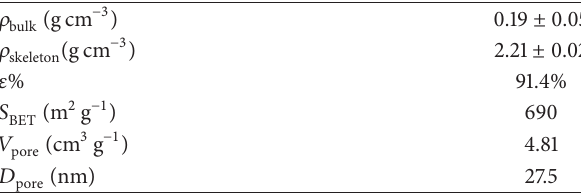
Table 4: Physical properties of the silica